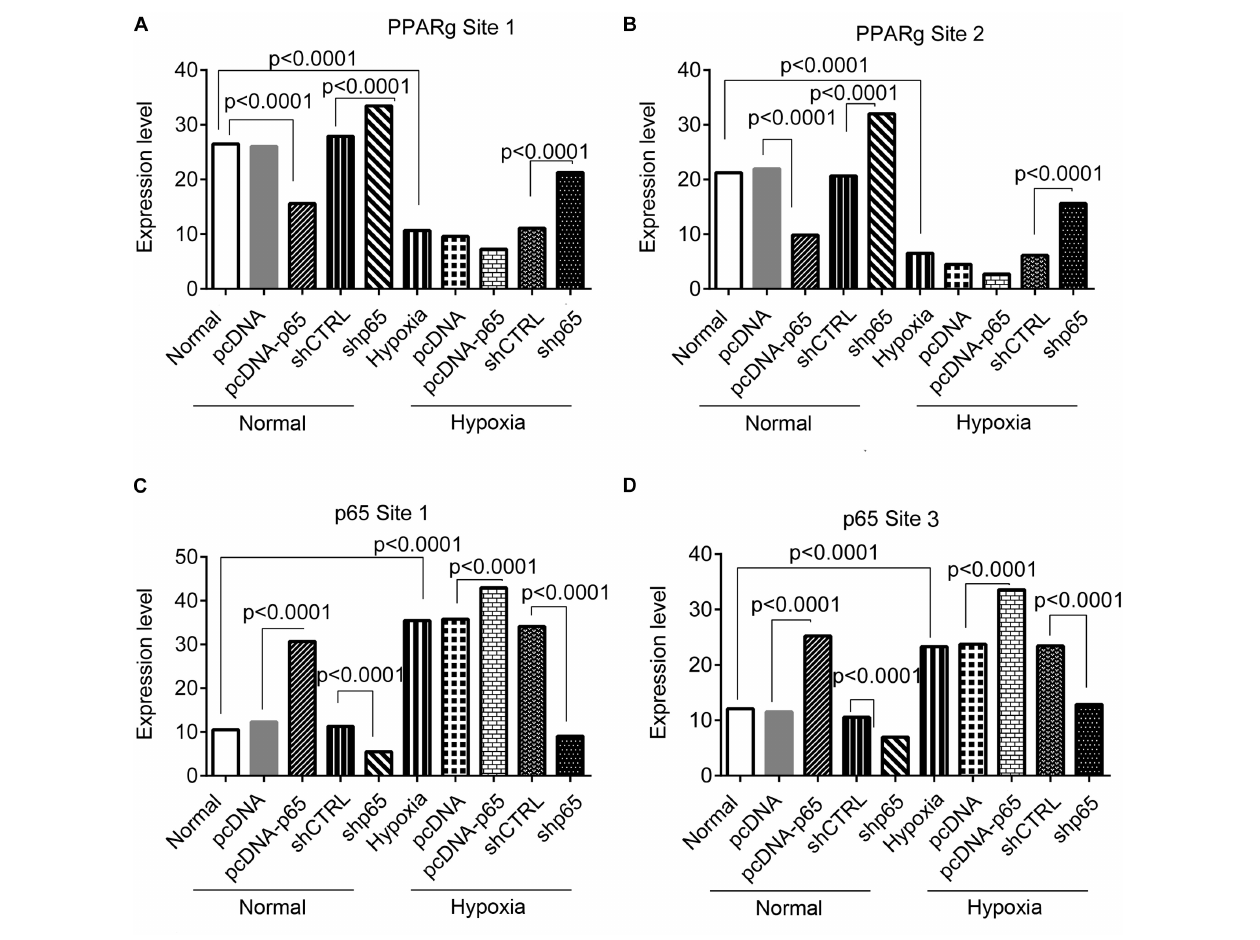
FIGURE 8 | The ChIP-PCR analysis for the binding of the p65 and Par proteins in the promoter regions of the TRPC6 gene in response to p65 overexpression or inhibition. (A,B) The PCR results of the DNA fragments including the promoter regions of the TRPC6 gene (site 1 and site 2 in Figure 7 ) enriched by the PPAR γ antibody. (C,D) The PCR results of the DNA fragments, including the promoter regions of the TRPC6 gene (site 1 and site 3 in Figure 7 ) enriched by the p65 antibody. Each experiment was repeated three times. The differences were analyzed using one-way ANOVA. CTRL, control.